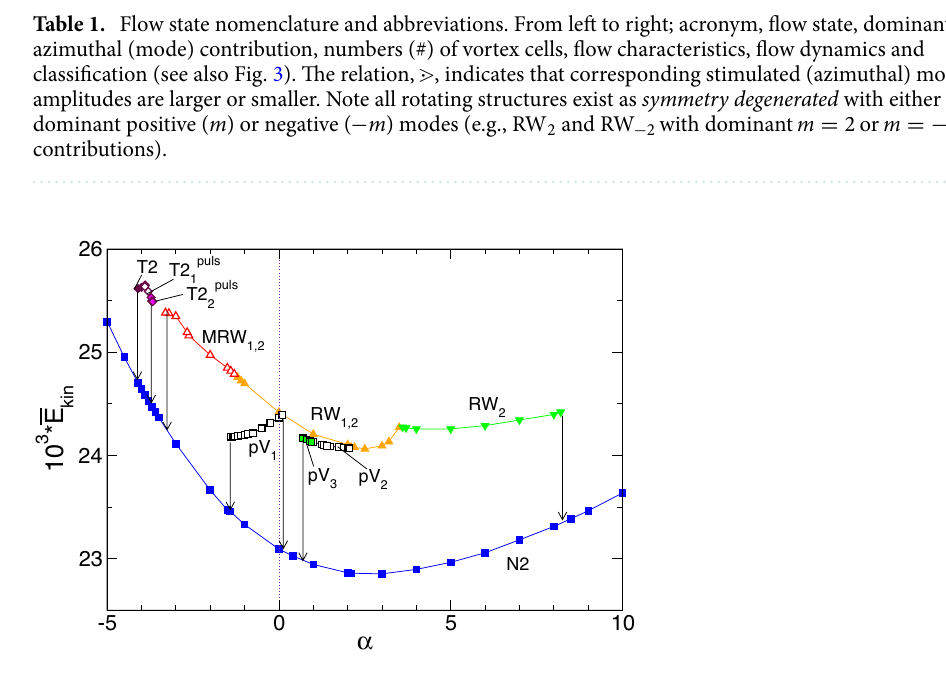
Figure 2. Bifurcation diagram. The total (time-averaged for unsteady flow solutions) modal kinetic energy, E kin , as a function of the radial Reynolds number, α . Different flow structures are labeled, and color-coded symbols are used to identify the flow states. Vertical arrows indicate transition behaviors when a flow state loses stability and changes to another stable state. Solid [open] symbols indicate stationary or rotating time dependent